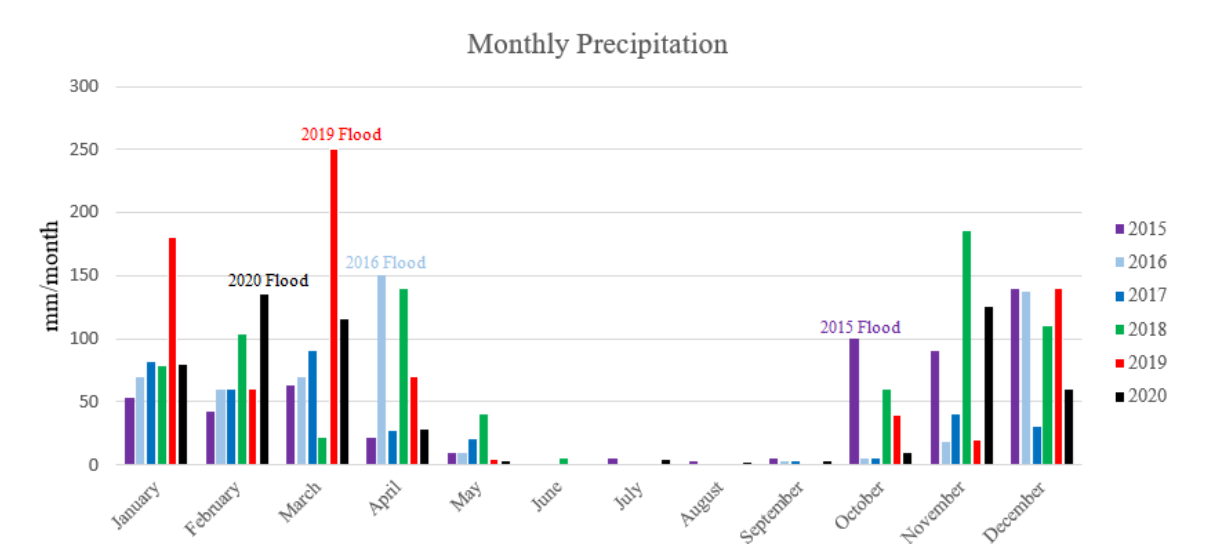
Figure 2. Comparison between the monthly precipitation from the Global Precipitation Measurement (GPM) data and flood events in Pol-e Dokhtar.